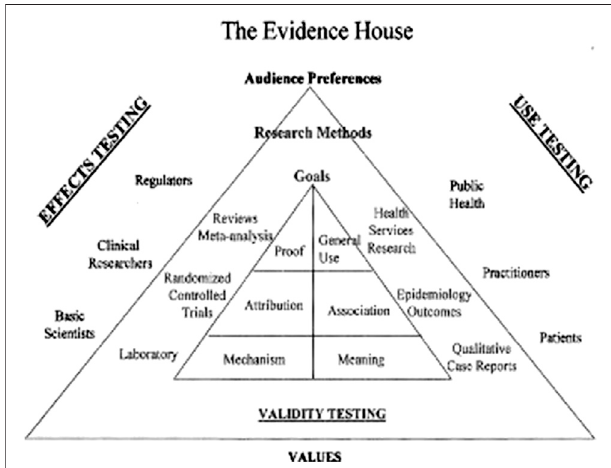
FIGURE 1 | The evidence house. ( “ Evidence, Ethics and the Evaluation of Global Medicine. ” From The Role of Complementary and Alternative Medicine: Accommodating Pluralism, Daniel Callahan, Editor, pp. 137 – 137. Reprinted with permission.